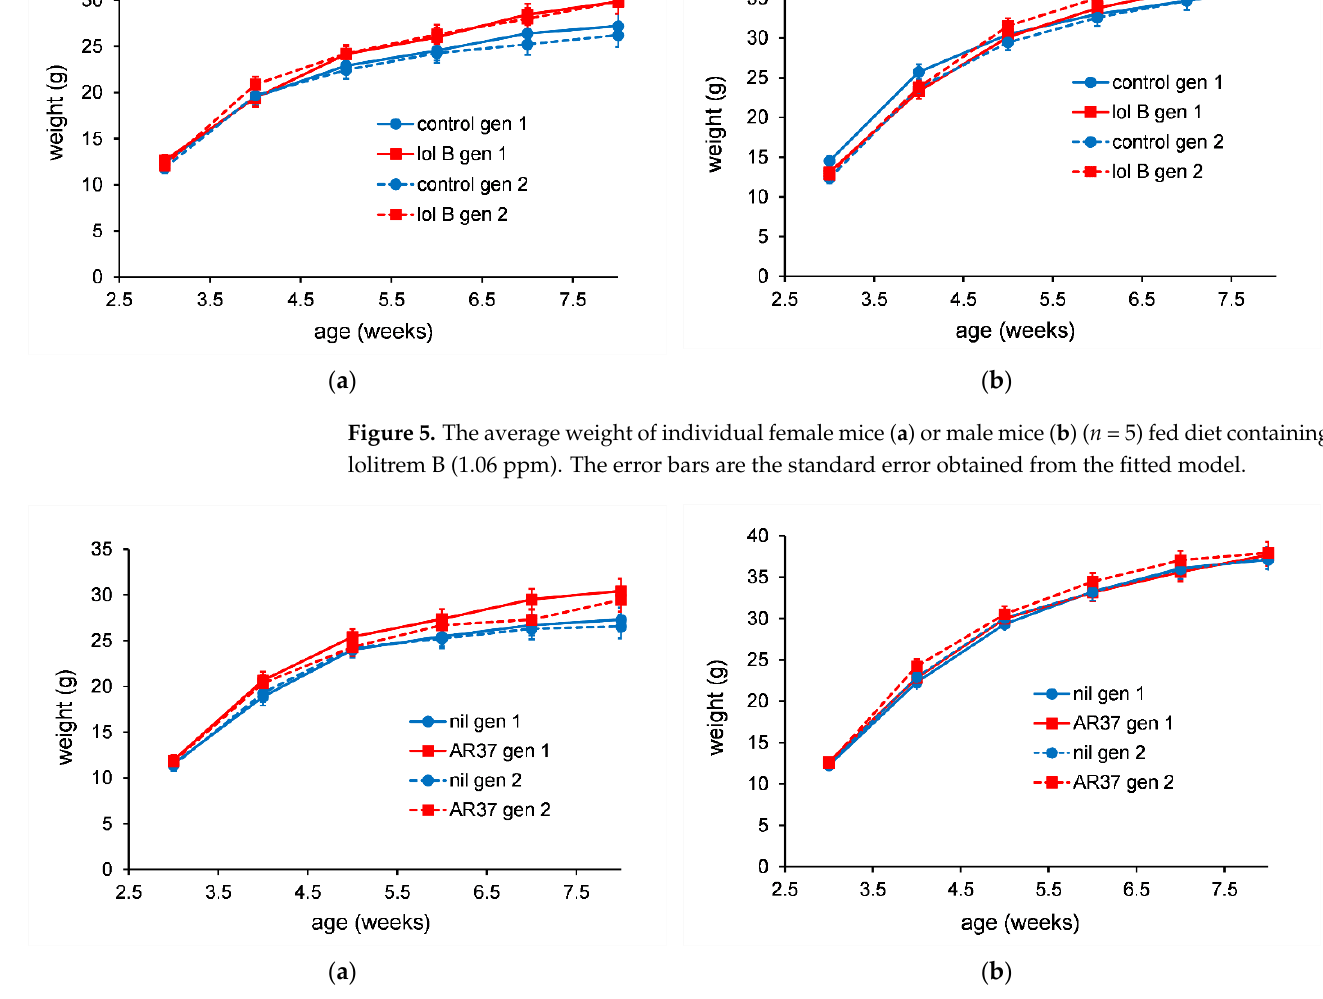
Figure 6. The average weight of individual female mice ( a ) or male mice ( b ) ( n = 5) fed diet contain- ing AR37 endophyte-infected seed (30%). The error bars are the standard error obtained from the fitted model.